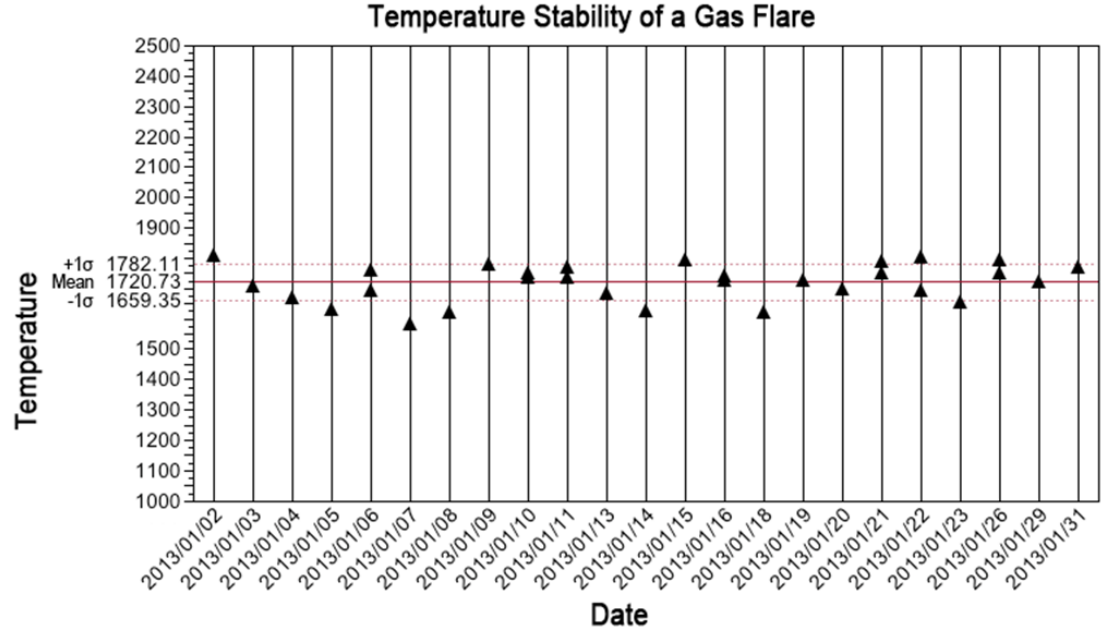
Figure 16. Temperature stability of a gas flare in Basra, Iraq during the month of January 2013.